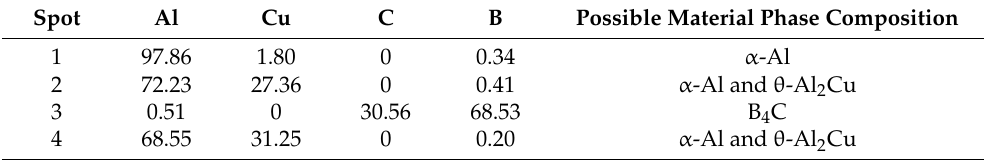
Figure 8. Microstructure and EDS composition analysis of deposited aluminum alloy parts with B 4 C powder. ( a ) SEM analysis, ( b – e ) EDS analysis. Table 4. The EDS analysis results for each point in Figure 8.